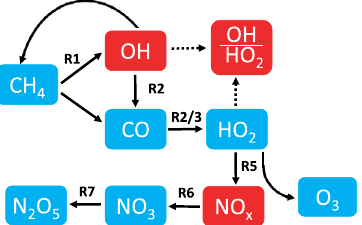
Fig. 5 Schematic of the relevant reactions linking methane, HOx and NOx. Species that decrease in ZAME are labelled in blue, and those that increase in red. Solid arrows represent reactions, with labels referencing the relevant reaction in the Methods section. The dashed arrows show how OH and HO 2 both contribute to the OH/HO 2 ratio. This is a simpli fi ed schematic of a more complex system that includes more feedbacks, such as between HOx, NOx and ozone.